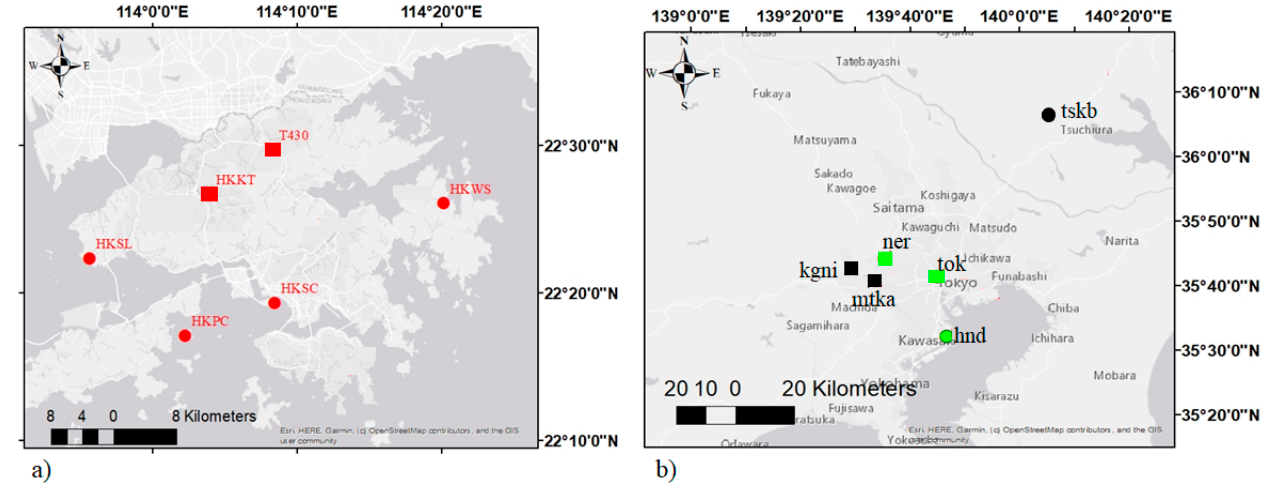
Figure 1. ( a ) Locations of GPS and meteorological stations in Hong Kong. ( b ) The locations of GPS stations and meteorological stations in Tokyo used for this study. Black points are GPS stations and green points are meteorological stations. Squares are urban stations and circles are rural or rural-like stations.